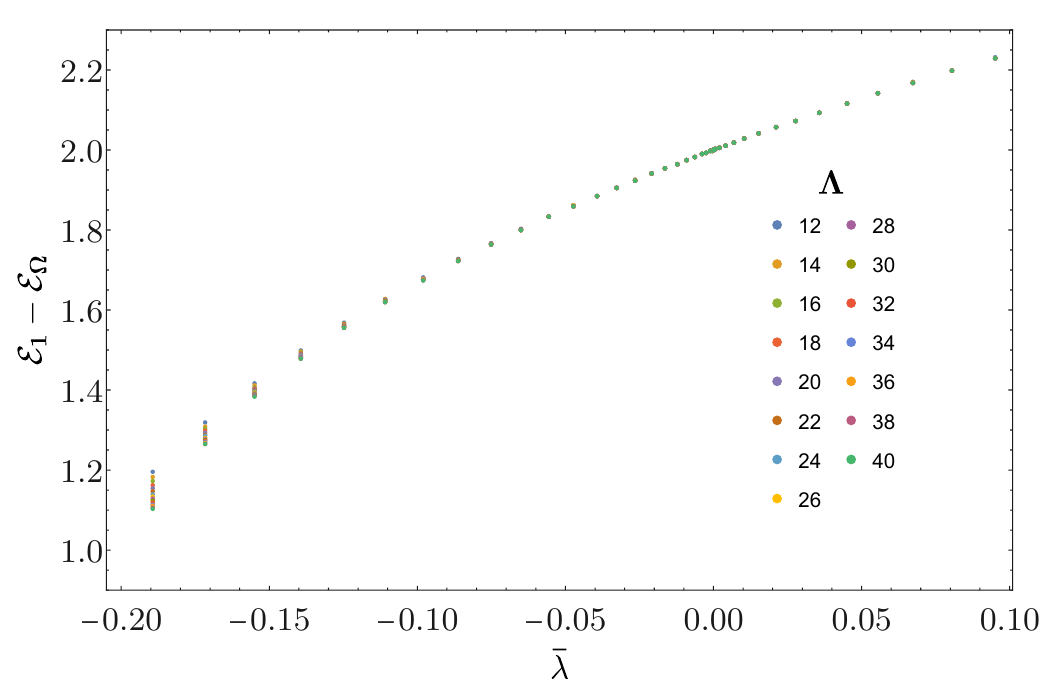
Figure 21. First excited state energy in the Lee-Yang model in a range of couplings around For the values of ¯ λ towards the left of the plot, the convergence with the cutoff Λ is very slow, and does not allow to extrapolate the value ¯ λ